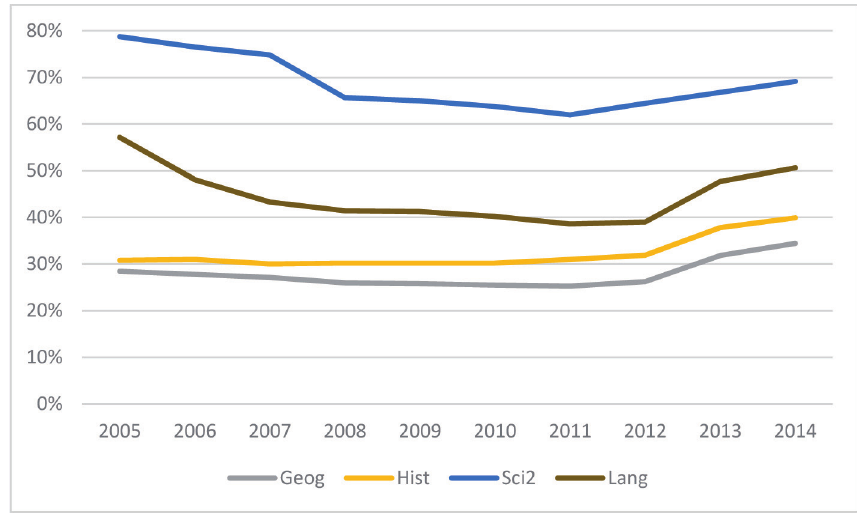
Figure 5: Percentage of pupils entered in GCSEs in EBacc subjects 2005 to 2014